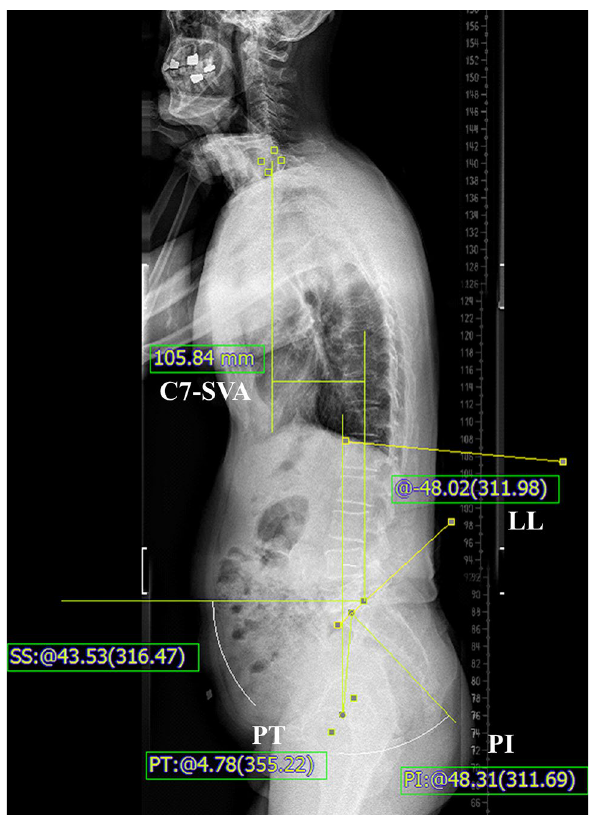
Figure 1. Radiological measurements. The C7 sagittal vertical axis (C7-SVA) is the horizontal distance from the C7 plumb to the posterior-superior corner of S1. Lumbar lordosis (LL) is measured between the superior end plate of L1 and S1. Pelvic incidence (PI) and pelvic tilt (PT) were measured from bicoxo-femora axis (midpoint of centers of the two femoral heads) to the midpoint of superior S1 endplate. The measuring tools are included in the picture archiving and communication